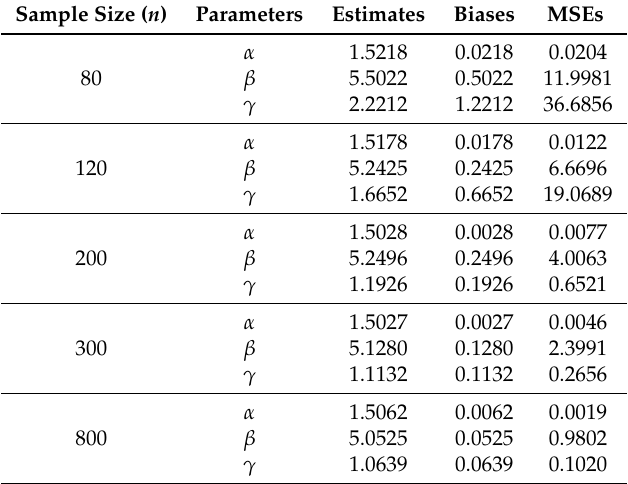
Table 3. Average MLEs, biases and MSEs for α = 1.5, β = 5 and γ = 1.